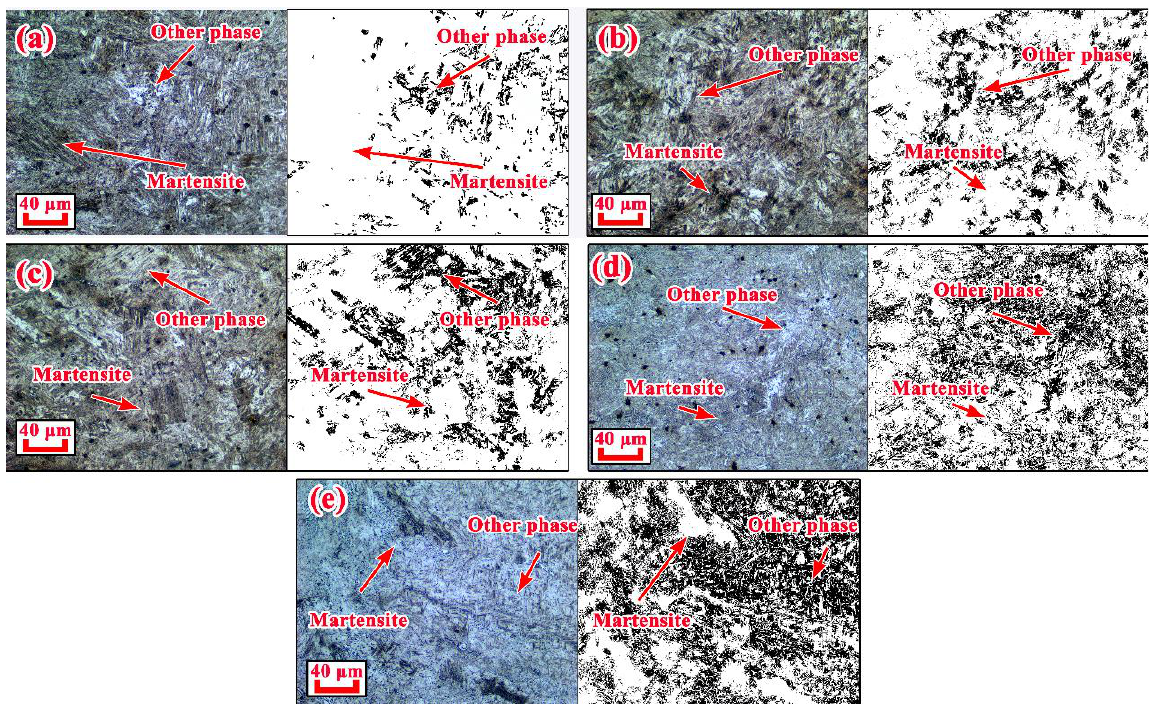
Figure 11. Metallographic microstructures with their processed images. ( a ) 28 °C; ( b ) 78 °C; ( c ) 128 °C; ( d ) 180 °C; ( e ) 250 °C.